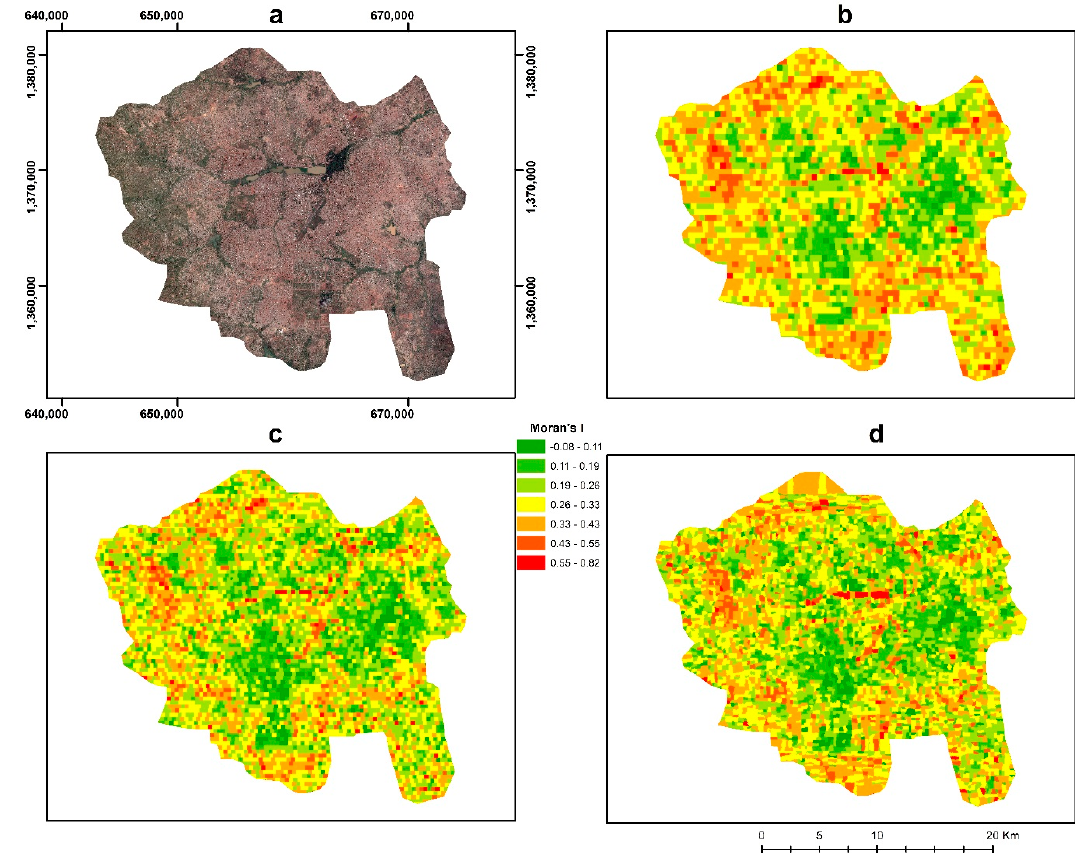
Figure 7. Spatial variation of Moran’s I (MI) values across Ouagadougou. ( a ) WorldView-3 RGB composite, partitioning by ( b ) P1 ( c ) P2 and ( d ) P3 approaches, respectively. The higher the MI value, the stronger the effect of spatial autocorrelation between a created segment and its neighbors.